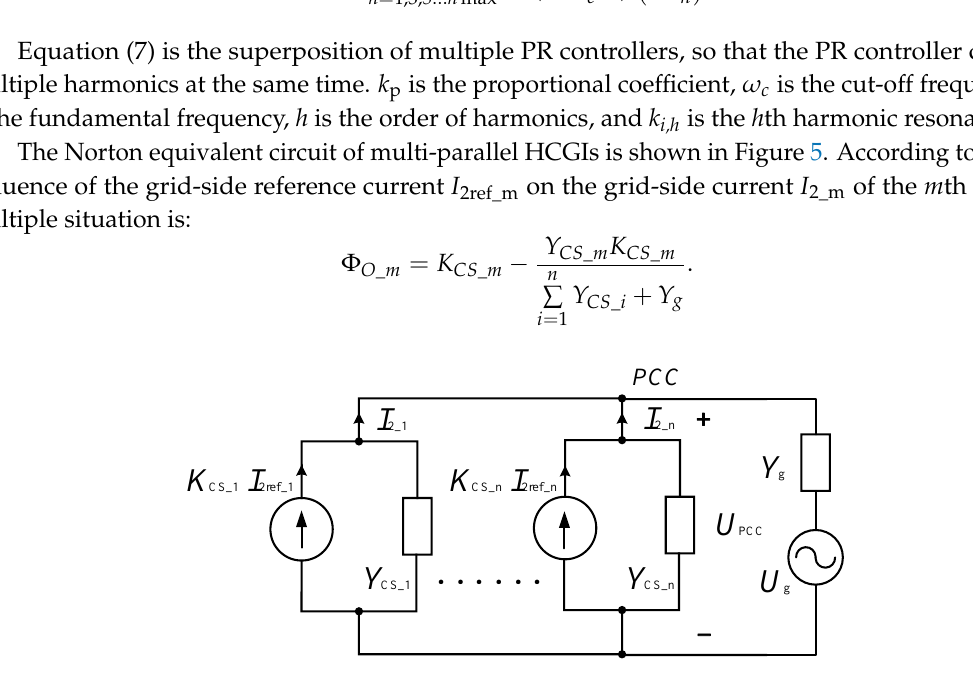
Figure 5. The Norton equivalent circuit of multi-parallel HCGIs system.